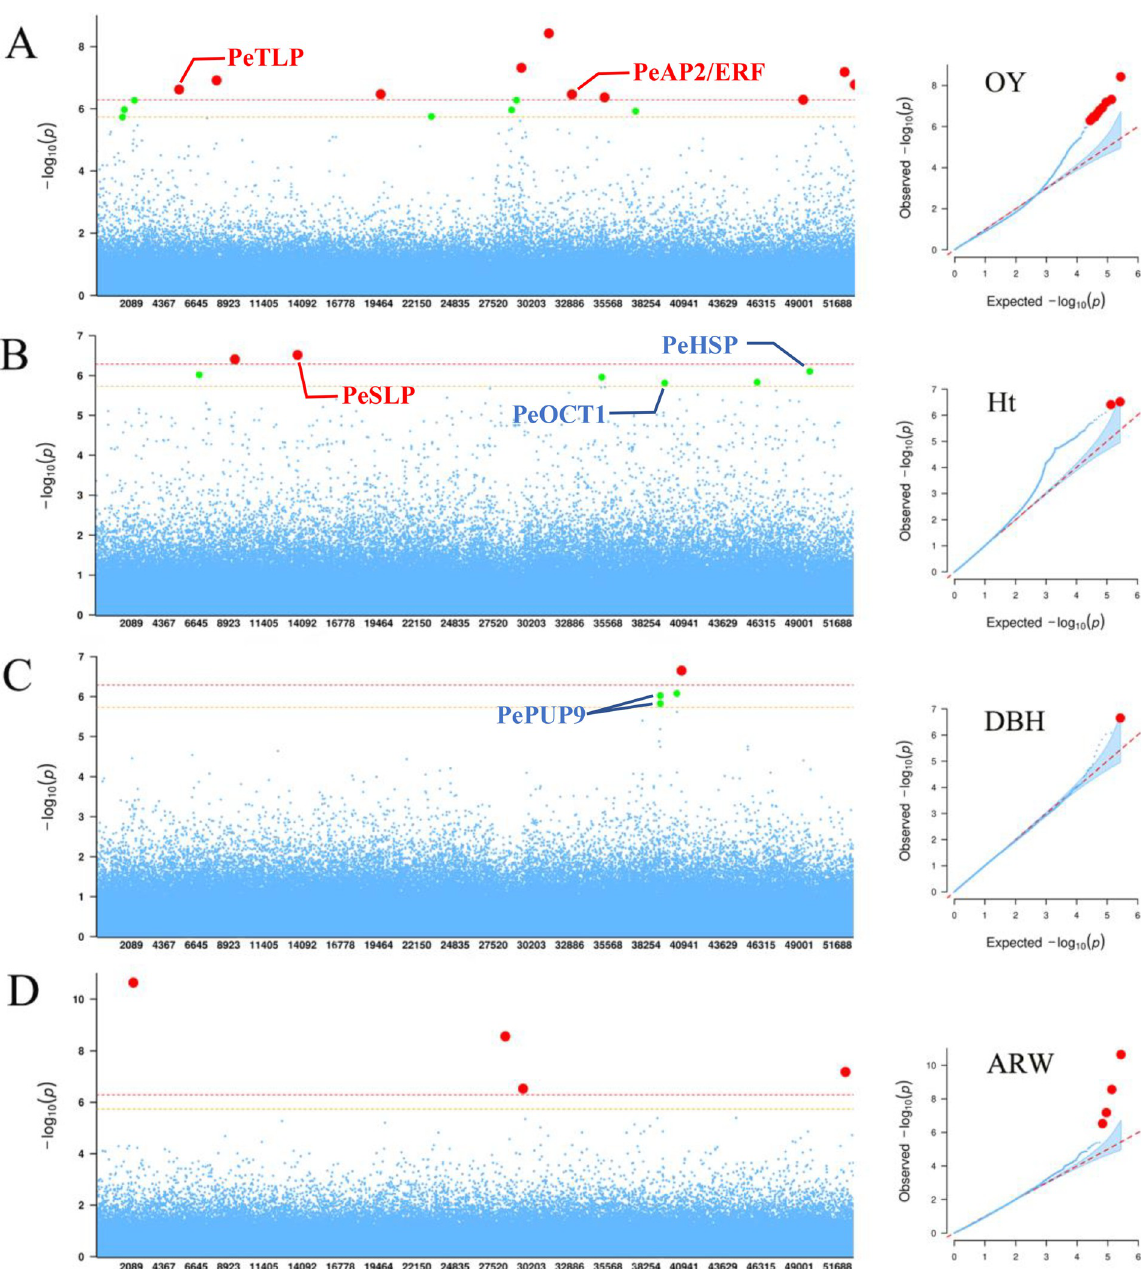
Fig 4. SNP-based association analysis. The x-coordinate is the transcriptome length. A The results of the associations between SNPs and oleoresin yield. B The results of the associations between SNPs and Ht. C Associations between SNPs and DBH. D Associations between SNPs and ARW. The right is the QQ plot, and the left is the Manhattan plot. Significant ( P < 1.9e-06) and extremely significant ( P < 9.4e-07) threshold lines are represented by orange and red dashed lines, respectively. Significant and extremely significant SNP sites are represented by enlarged green and red solid points,